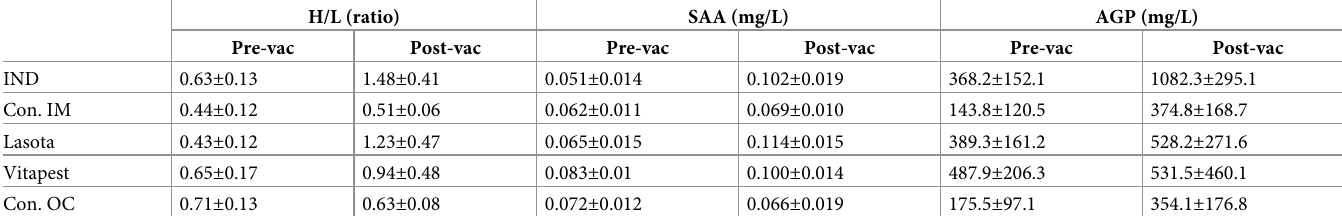
Table 1. Shows H/L ratio, SAA and AGP levels for vaccinated and control groups at pre-vaccination and day-1 after vaccination. All data are expressed as mean ± SD, n = 10 birds per sampling